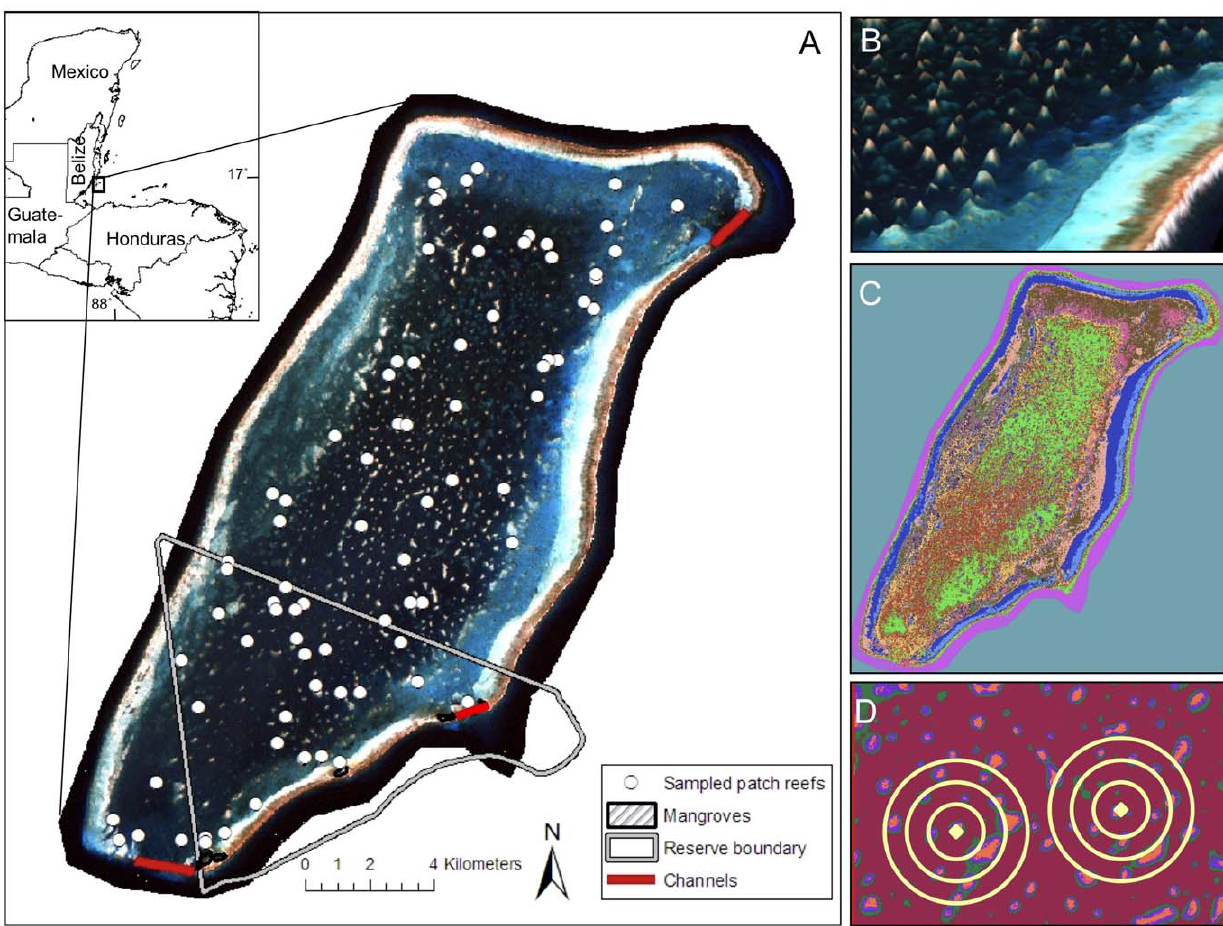
Figure 1. Remote sensing imagery of sampling locations and benthic habitats for Glover’s Atoll, Belize. (A) IKONOS satellite imagery of Glover’s Atoll showing patch reef study site (white circles). (B) ENVI bathymetric map of NE section of lagoon. (C) Habitat classification map featuring 12 benthic habitat classes. (D) Delineation of 200 m, 500 m, and 1 km buffers around patch reef sites to generate patch density metrics.